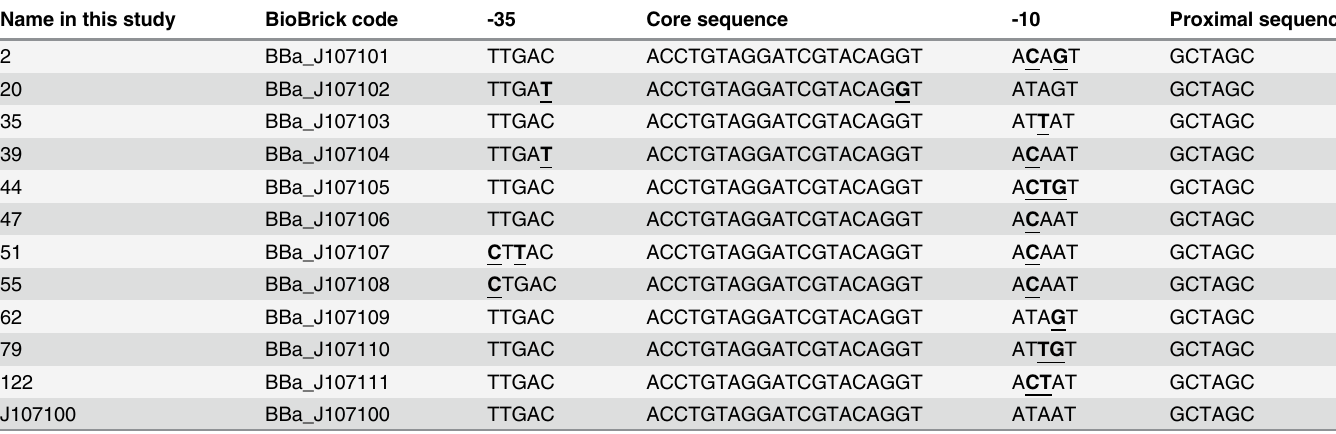
Table 3. Sequences of the promoters belonging to the LuxR-repressible promoter